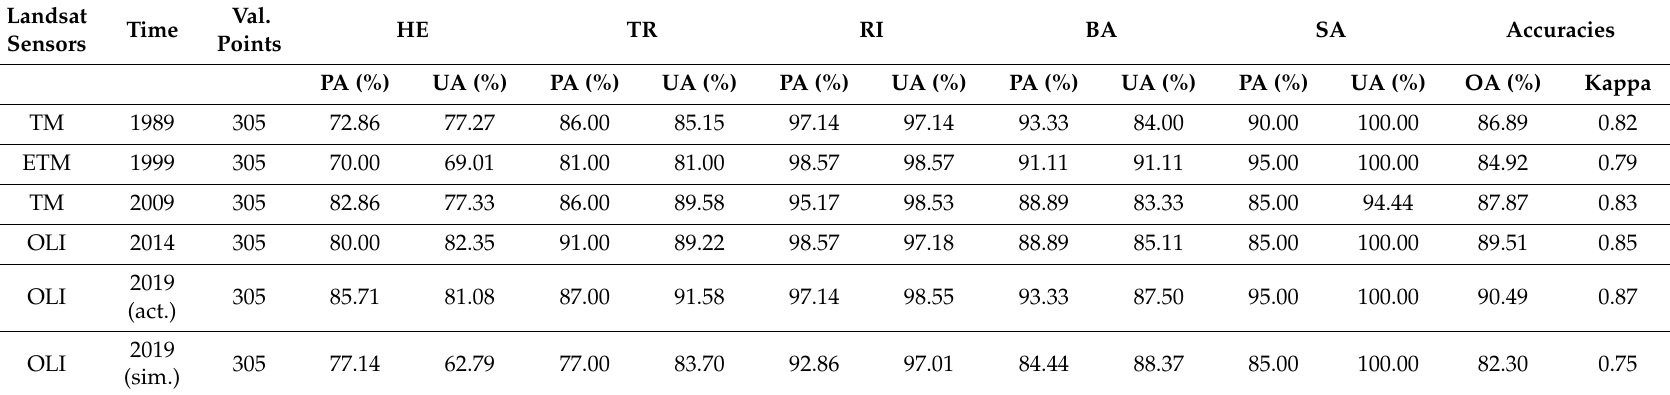
Table 1. The producer, user and overall accuracies of 5 TM (1989), 7 ETM (1999), 5 TM (2009), 8 OLI (2014, 2019 act., 2019 sim.) images using MLC techniques. Landsat